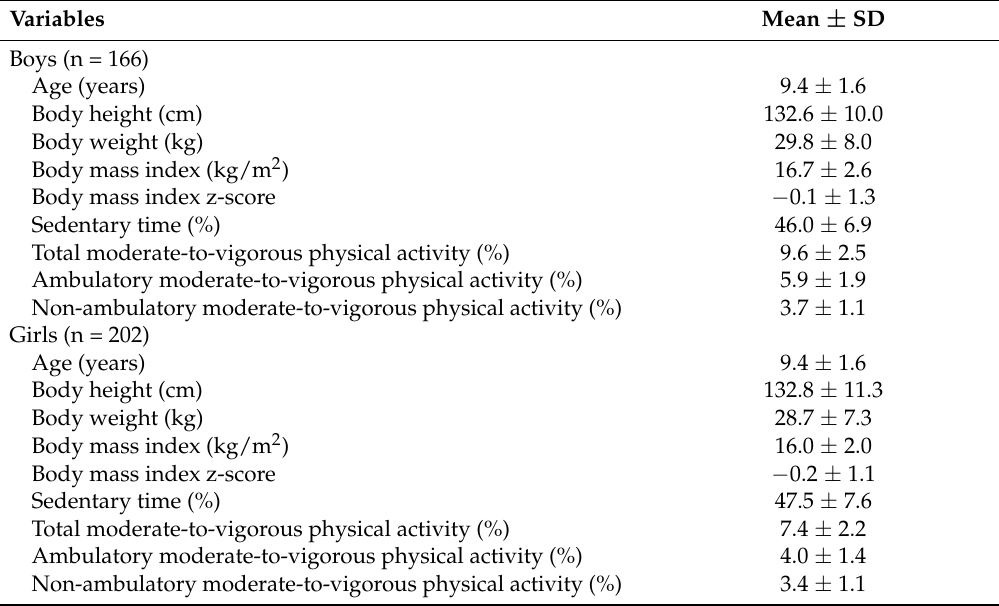
Table 1. Physical characteristics of the study participants, grouped according to age and